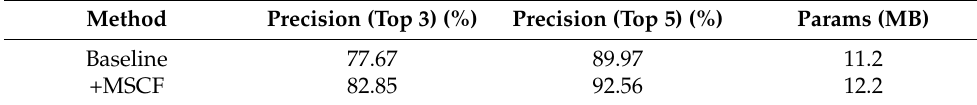
Table 4. Effects of the MSCF module on the CTI_RSCloud dataset.